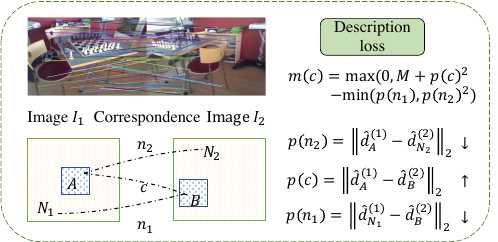
Figure 8. The calculation demonstration of feature description loss. (The target of the loss function is Figure 4.8.The calculation demonstration of feature description loss to minize p ( n 2 ) and p ( n 1 ) , and maximize p ( c )